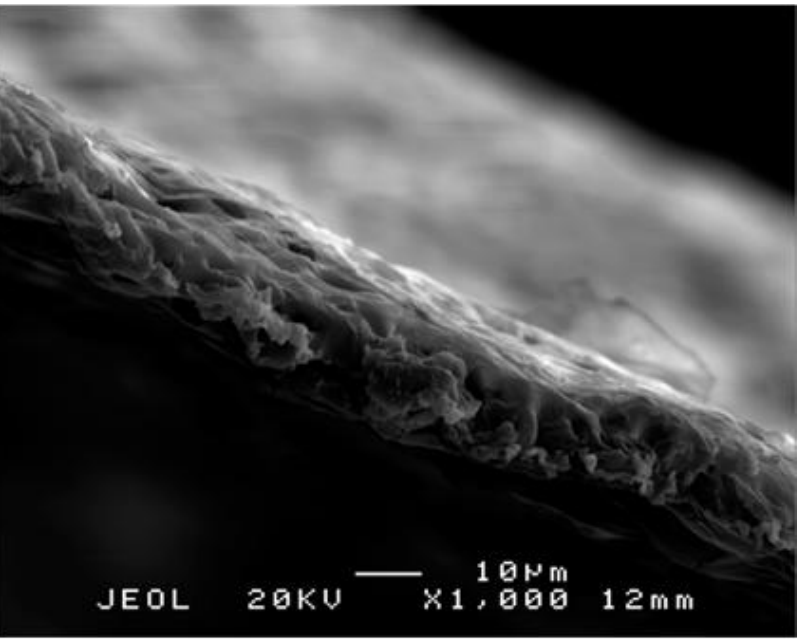
Figure 3. Scanning electron microscope image of a porous polylactide film. The thickness of film ranges from 10 to 20 µm. Note: Scale bar = 10 µm .